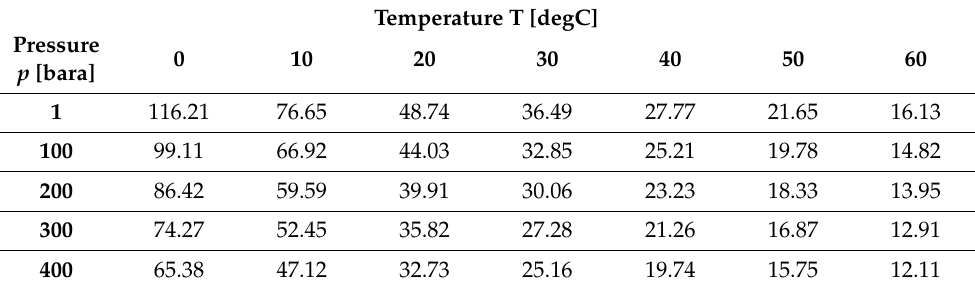
Table 3. Scaling tendency for barium sulphate of a mixture of 50/50 B3 field’s produced water and